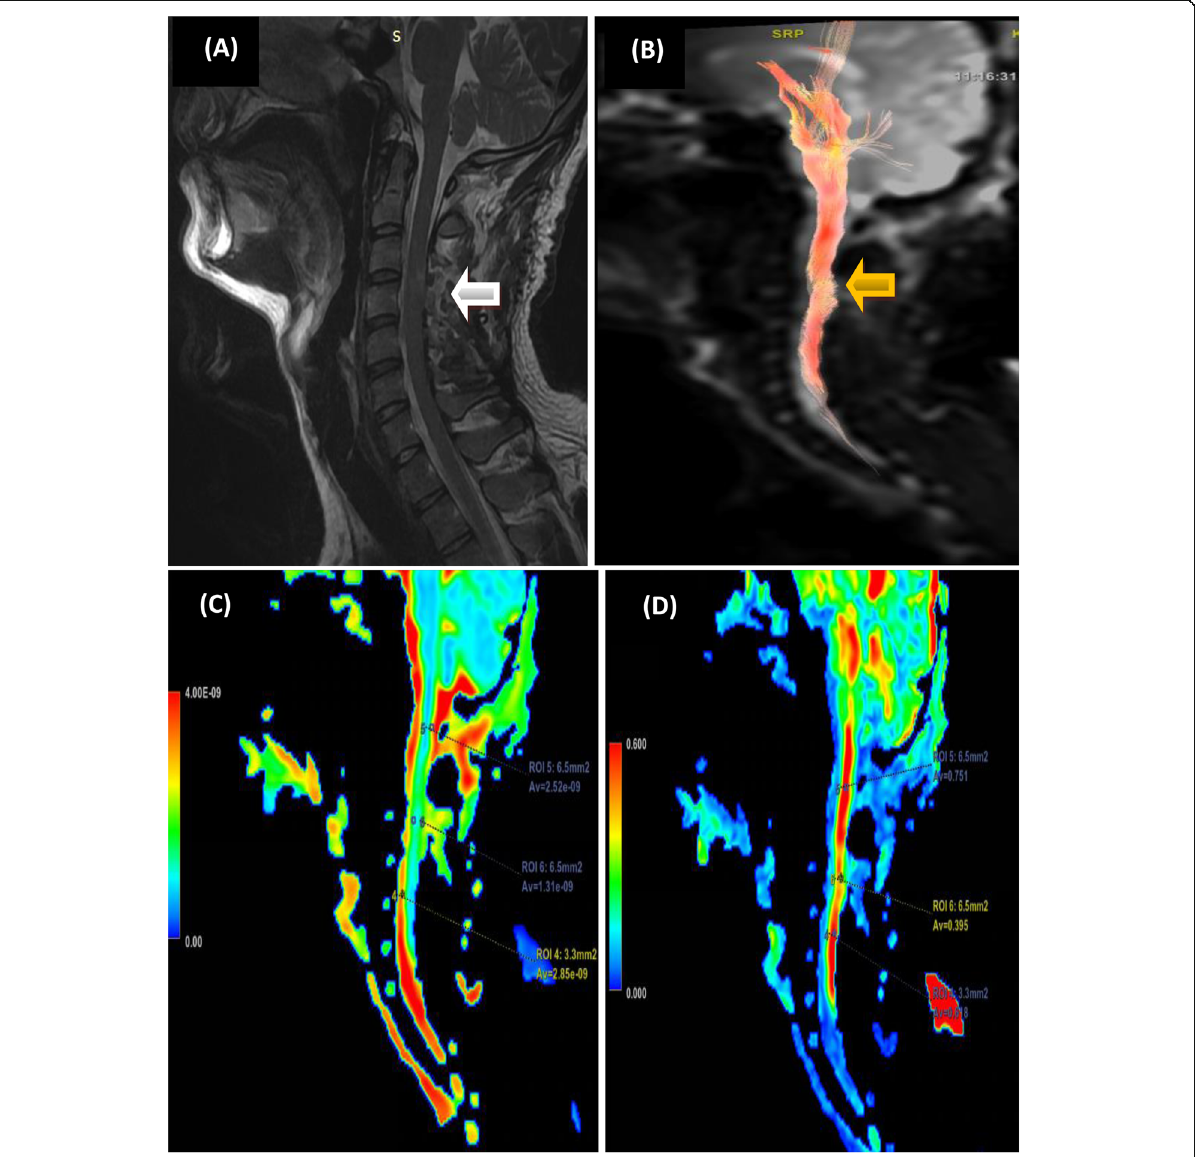
Fig. 2 a – d A 22-year-old male patient hit forcibly by a blunt object on his back. Neurologically, he was ASIA grade C. a Sagittal T2-weighted MR image acquired at 1.5 T shows abnormal spinal cord signal at the level of C4-5 (white arrow). b Fiber tractography image shows partially interrupted white matter tract of cervical spinal cord with attenuated fibers (yellow arrow). c Sagittal color coded ADC map image shows an ADC value at the injury level (1.31) lower than values above (2.52) and below (2.85) the injury level. d sagittal color coded FA map image shows lower FA value at the injury level (0.395) than values above (0.751) and below (0.678) the injury